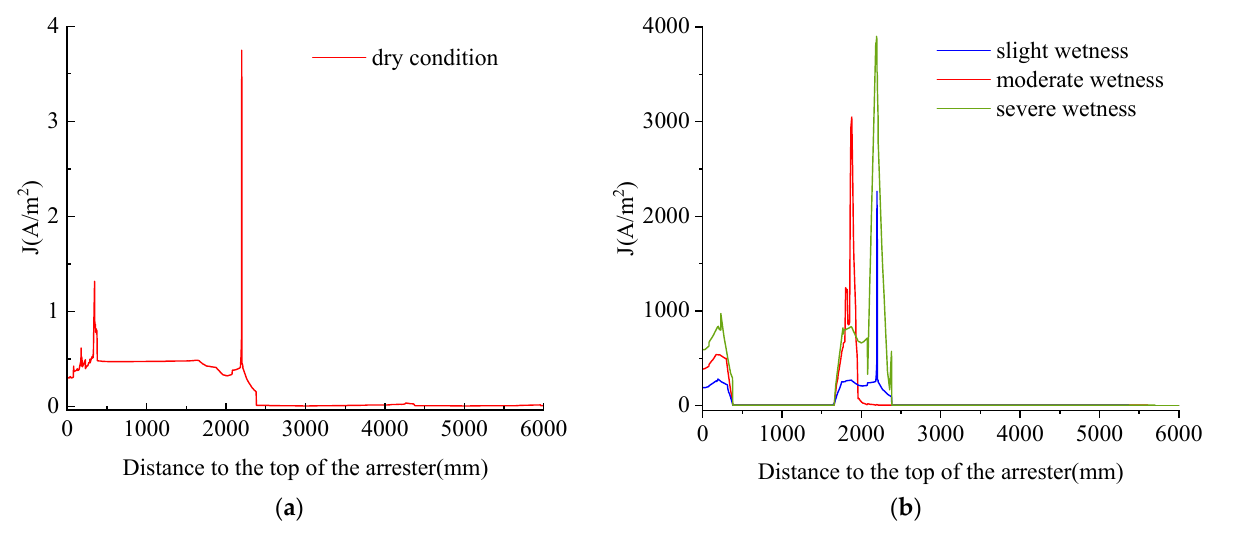
Figure 14. Changes in the current density of the arrester under different moisture conditions. ( a ) dry conditions; ( b ) different degrees of moisture.